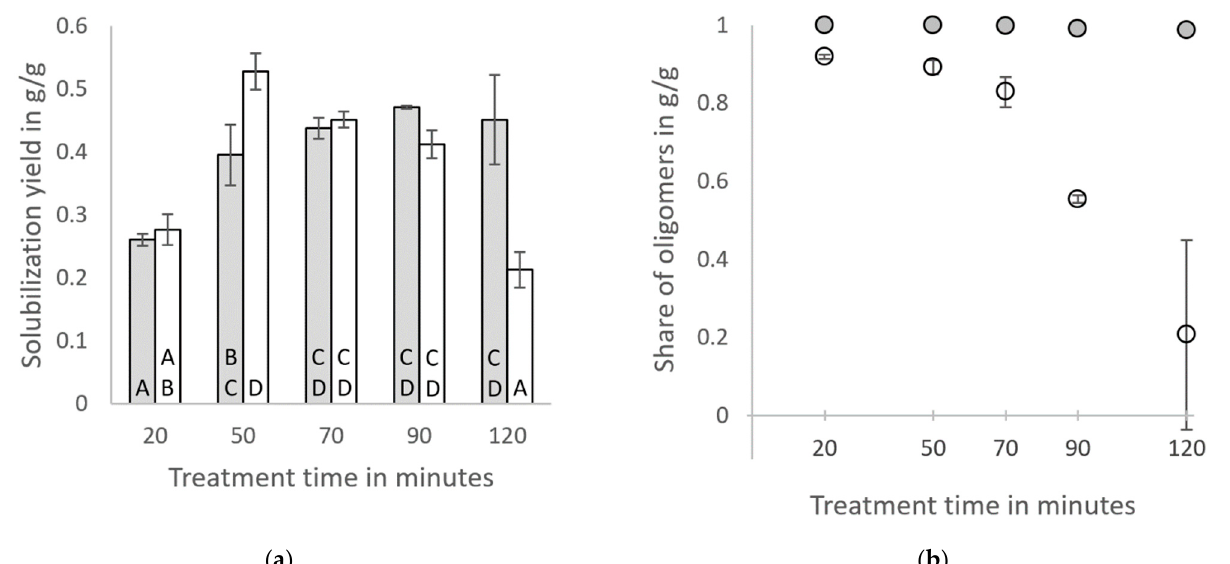
Figure 4. Analysis of solubilized sugars in the hydrolysate after hydrothermal treatment of raw digestate (filled in gray • ) compared with washed digestate (no filling ). ( a ) Solubilization yield of the hemicellulose-related sugars xylose and arabinose as a function of hydrothermal treatment time; ( b ) share of dissolved sugars bound in oligomers among total dissolved sugars (free monomers + oligomers). The error bars reflect the standard deviation observed between two hydrothermal treatments performed at the same conditions. The letters A to D indicate whether the differences between the mean values are significant according to the Tukey–Kramer test at a significance level of α = 0.05. Results that share a letter are not significantly different from each other.